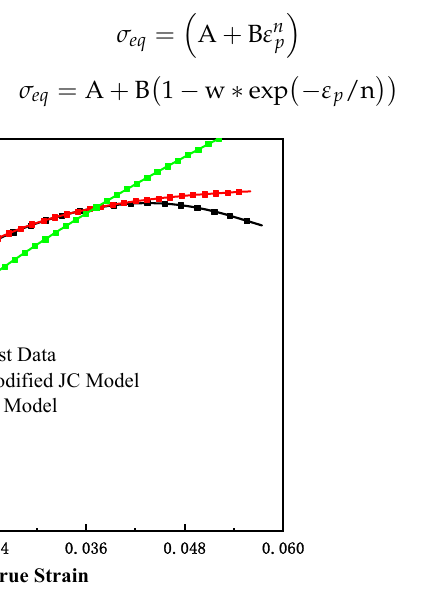
Figure 4. The comparison of model predictions with experimental results at strain rate 0.001 s − 1